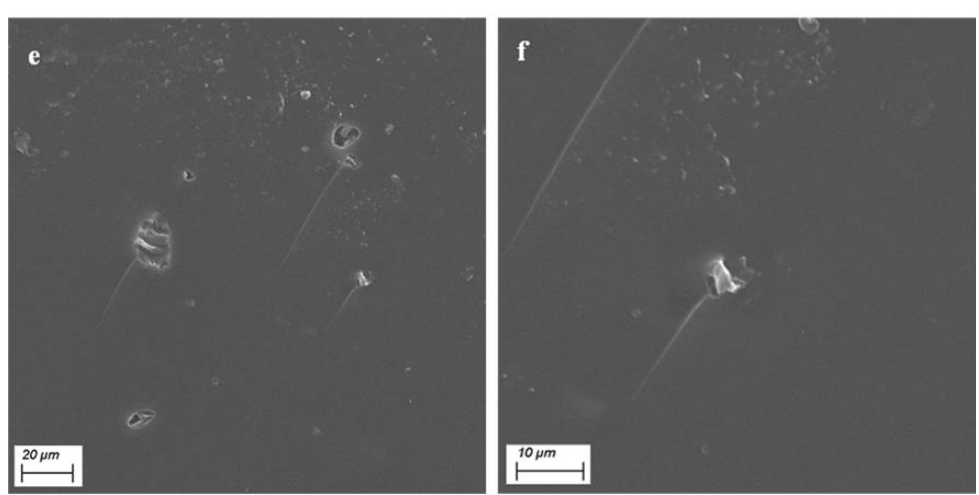
Figure 6. Typical SEM micrographs of ( a , b ) unfilled P.A.20:80 and samples containing 0.60 wt.% ( c , d ) MCC and ( e , f ) CNC. ( c , d ) MCC and ( e , f ) CNC.